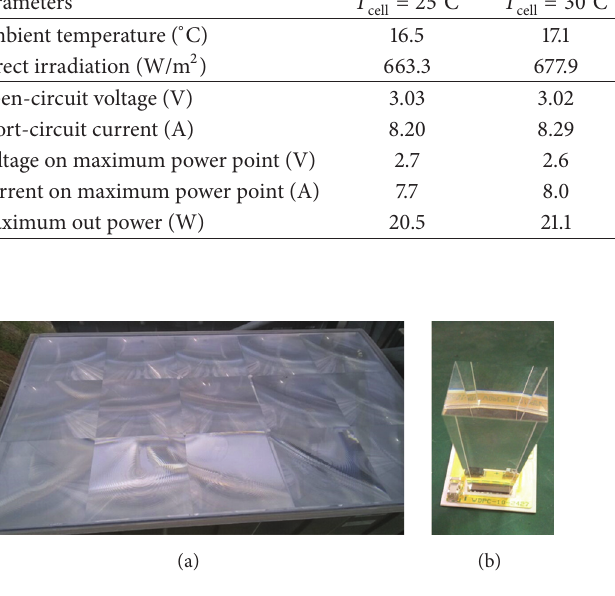
Figure 8: Photo of Fresnel solar concentrators.